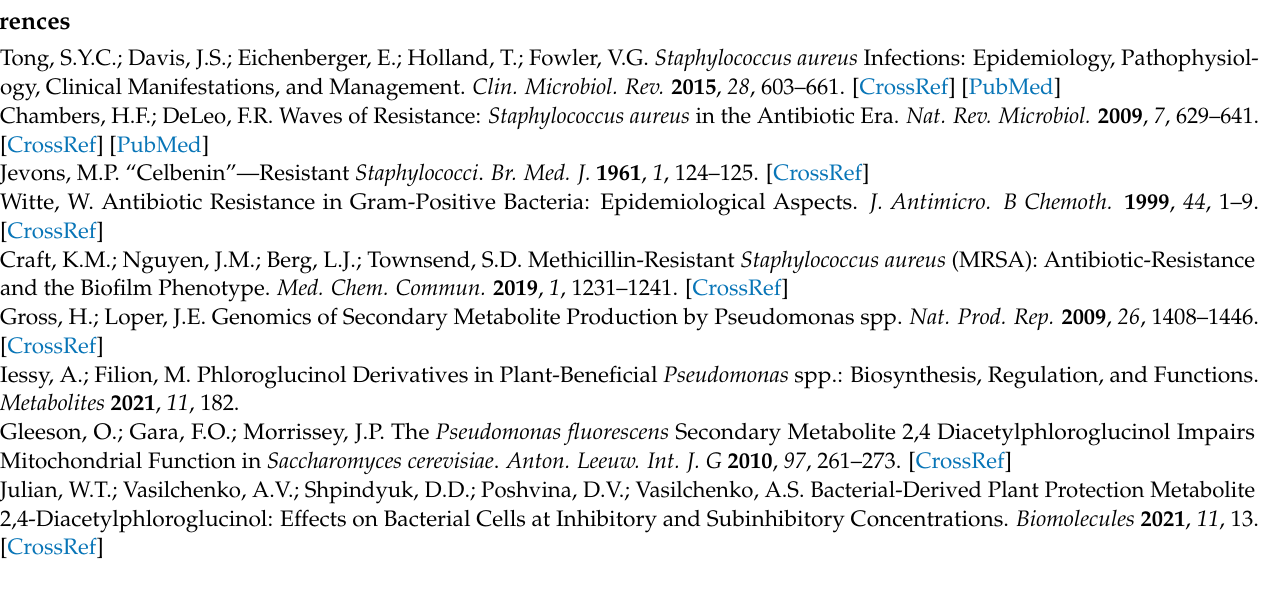
tions; Figure S4: Antifungal activity of P. protegens FJKB0103 and its mutants against Rhizoctonia solani ; Figure S5: The swarming motility of P. protegens FJKB0103 and its mutants on soft (0.3% w / v ) LB agar plates; Table S1: Strains and plasmids used in this study; Table S2: Primers used in this study; Table S3: Biochemical characteristics of strain P. protegens FJKB0103 and P. protegens CHA0 T ; Table